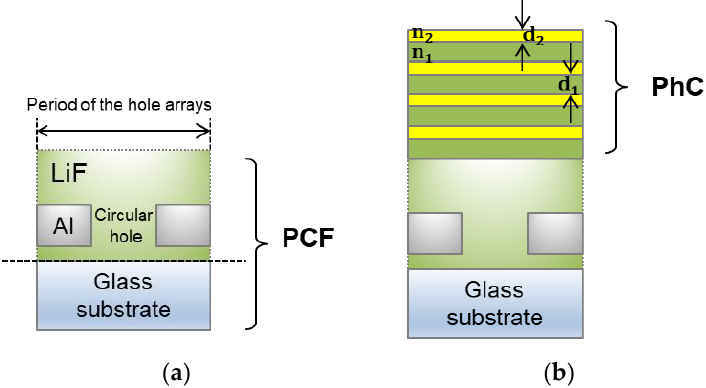
Figure 1. Schematics of the structure of plasmonic color filters (PCFs). ( a ) The reference PCF, ( b ) the proposed PCF in which a one-dimensional photonic crystal (PhC) is integrated onto the top of the reference PCF.